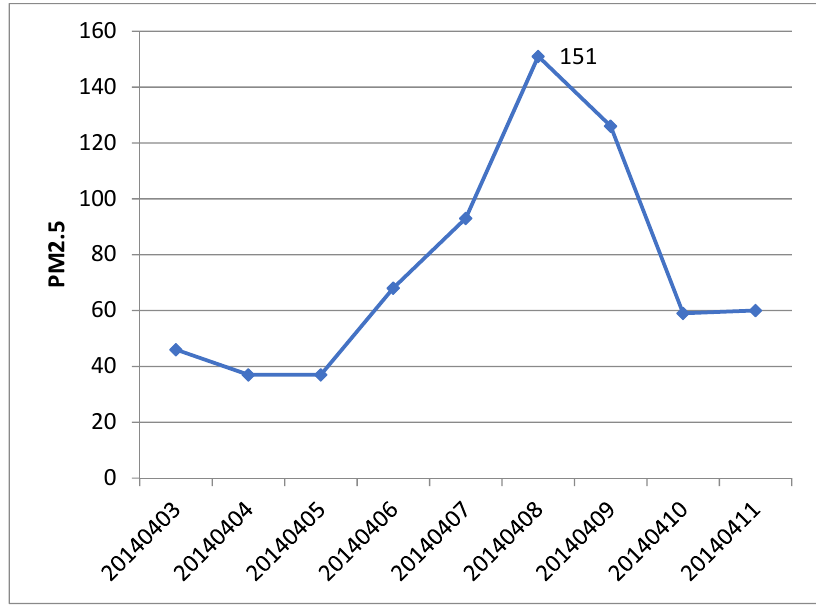
Figure 8. Measured PM 2.5 concentrations (µg/m 3 ) in Baoding.